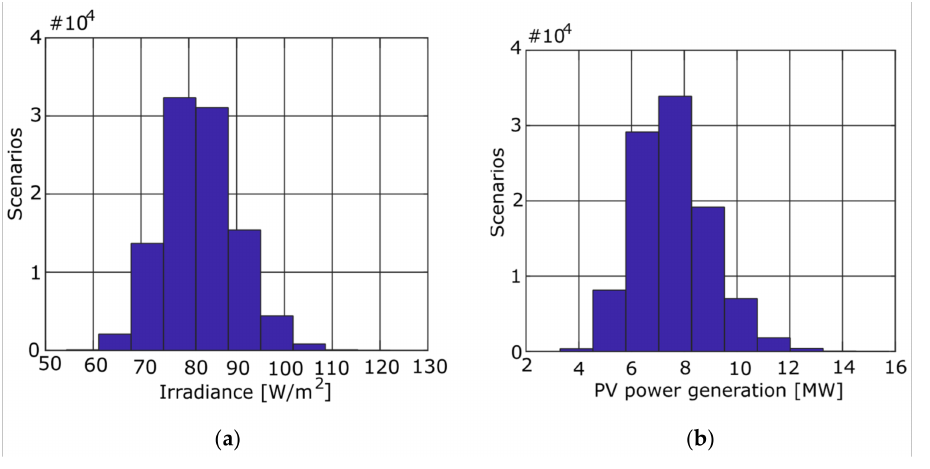
Figure 4. Histograms of ( a ) irradiance and ( b ) solar power generated. (# means 10 4 ). Penalties due to UCs are determined, and UCs are calculated while solar Gen varies (Figure